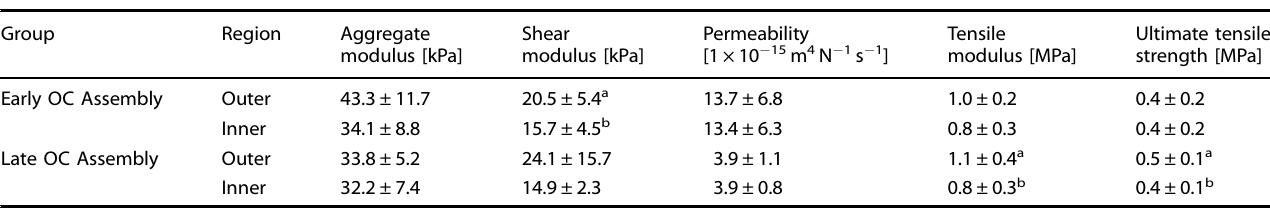
Table 2. Neocartilage regional mechanical properties.